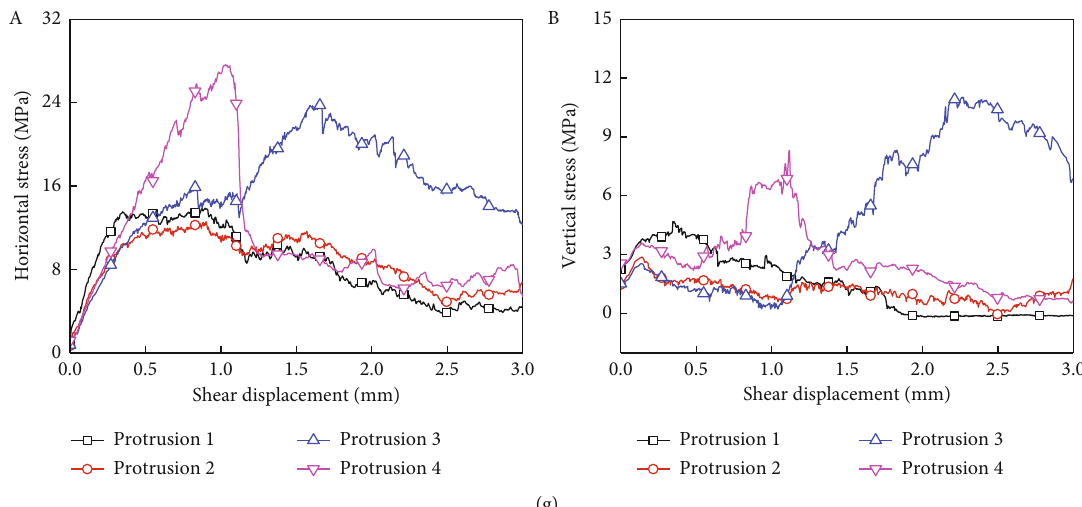
Figure 16: Variation curves of horizontal and vertical stresses of di ff erent joint protrusions during shear process: (a) joint 1; (b) joint 2; (c) joint 3; (d) joint 4; (e) joint 5; (f) joint 6; (g) joint